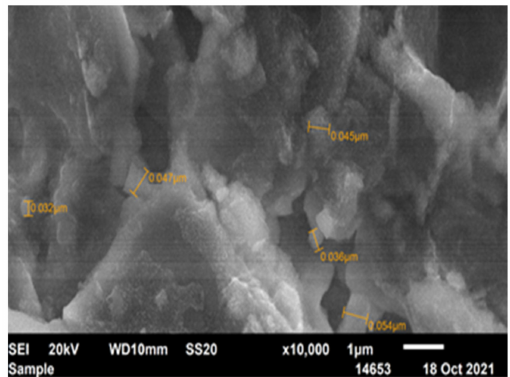
Figure 12. SEM image of CoFe 2 O 4 . Table 3. Data of elemental analysis of CoFe 2 O 4 (in wt.%).